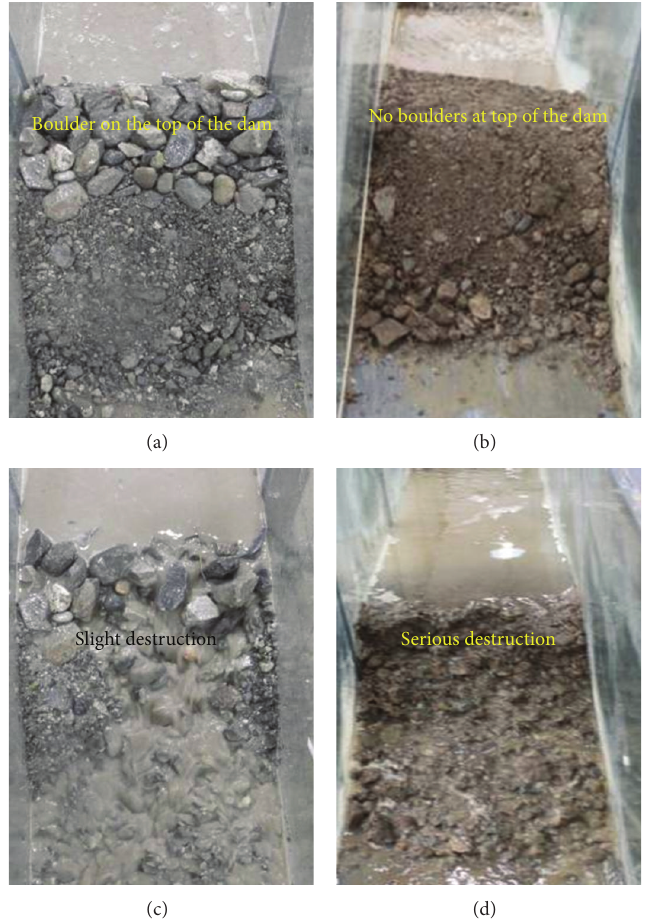
Figure 10: Experiments on the impact of boulders on the top of the dam on dam break mechanisms: (a) landslide dam with a boulder- covered top before dam break, (b) landslide dam without a boulder-covered before dam break, (c) after dam break of a landslide dam with a boulder-covered top (d) after dam break of a landslide dam without a